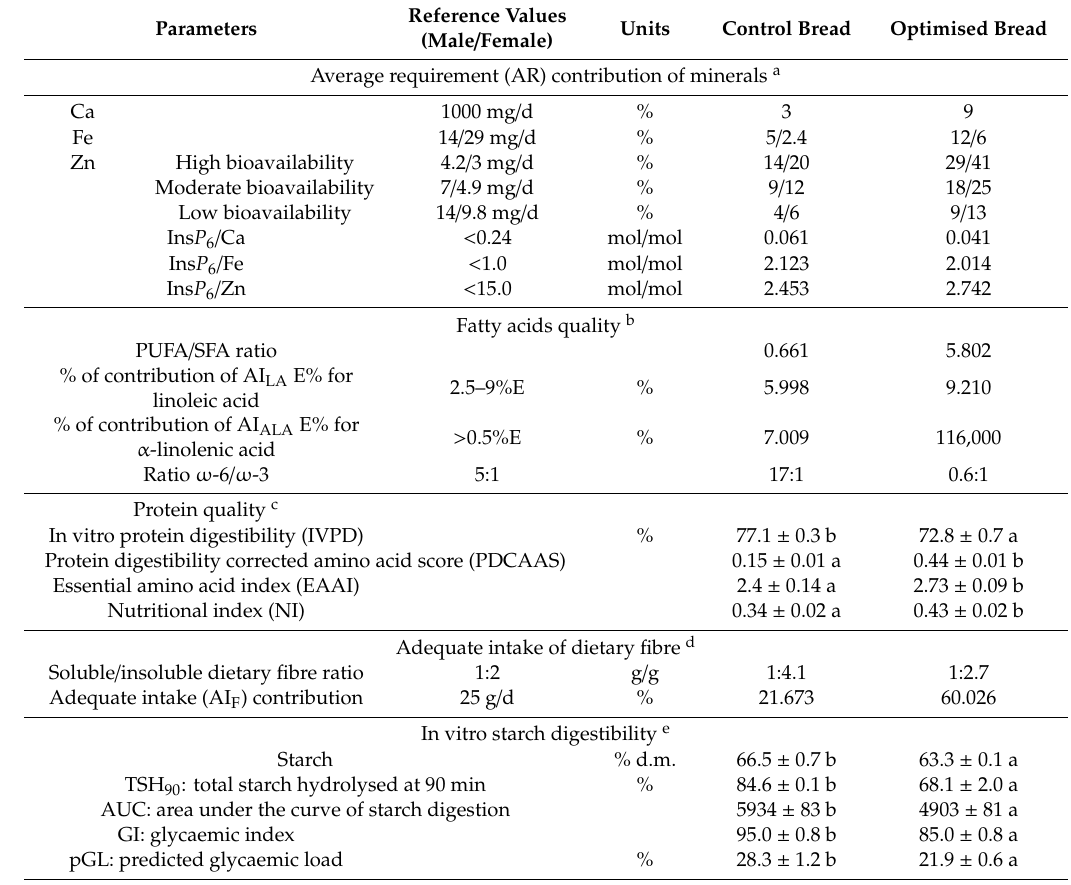
Table 5. Nutritional composition of control and optimised